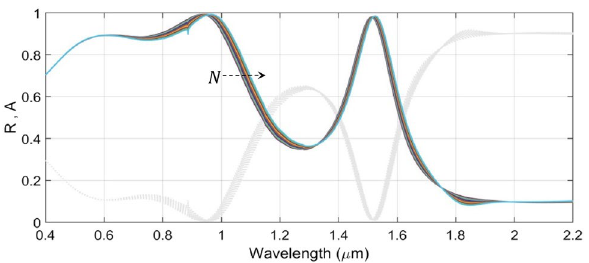
Figure 9. Effect on the absorption/reflection spectra due to altering the number of graphene layers in the range of 1 to 10 under fixed values of d GST1 (= 130 nm), d GST2 (= 70 nm), d s1 (= 100 nm), d s2 (= 120 nm), and d s3 (= 60 nm). The dashed arrow represents increase in the value of N .